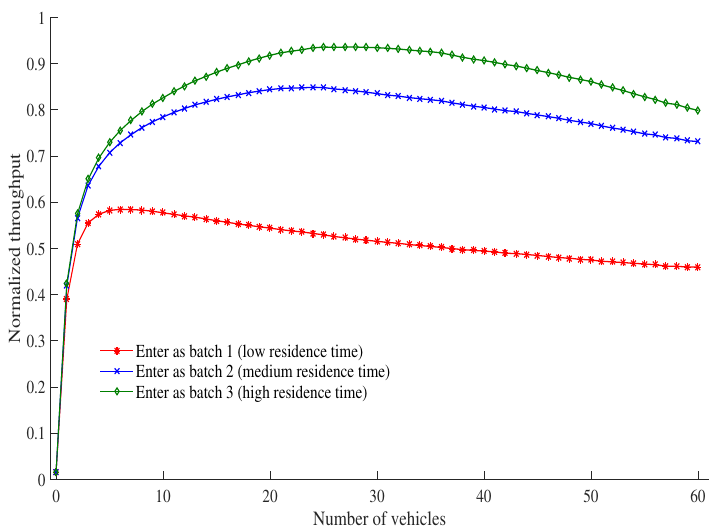
Figure 12. Total normalized throughput vs. number of